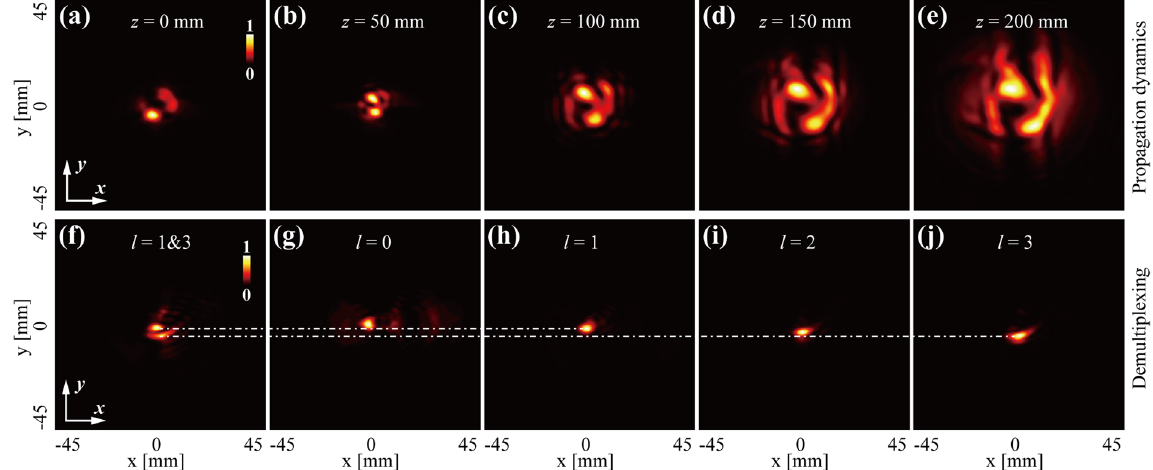
Figure 5. The propagation dynamics and the multiplexing of the multiplexed THz CAVB with l = 1&3. ( a )–( e ) The xy normalized intensity profiles of the multiplexed THz CAVB at the position of z = 0 mm, z = 50 mm, z = 100 mm, z = 150 mm and z = 200 mm. ( f ) The measured intensity profile of the multiplexed THz CAVB with l = 1&3. ( g )–( j ) The measured intensity profiles of the THz CAVBs with individual OAM mode ranging from l = 0 to l =